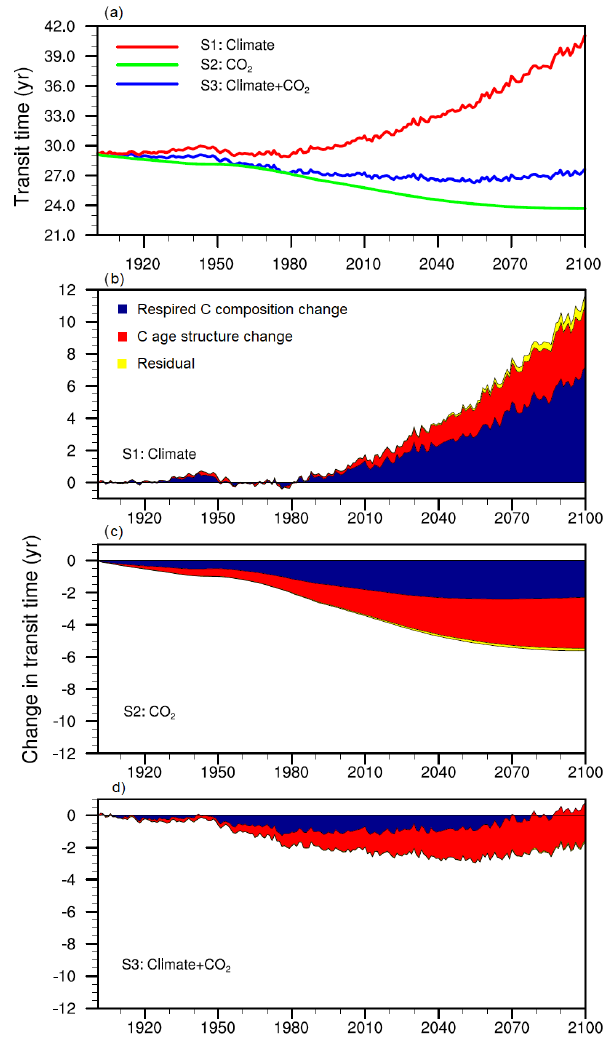
Figure 3. CABLE simulates changes of global C transit time for each of the three scenarios in (a) S1: climate warming scenario (red line), S2: rising atmospheric [CO 2 ] scenario (green line), and S3: combined climate warming and rising atmospheric [CO 2 ] scenario (blue line). The changes in global ecosystem C transit time are sep- arated into three contributions based on Eq. (6): contribution from respired C composition change, contribution from C age structure change, and residual (b–d)